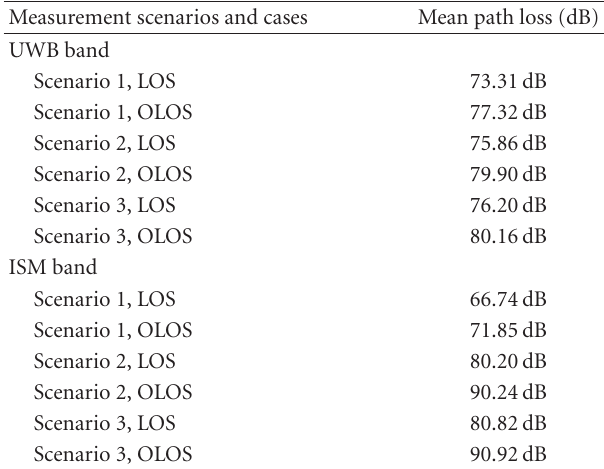
Table 2: Average path loss (PL) within the measured